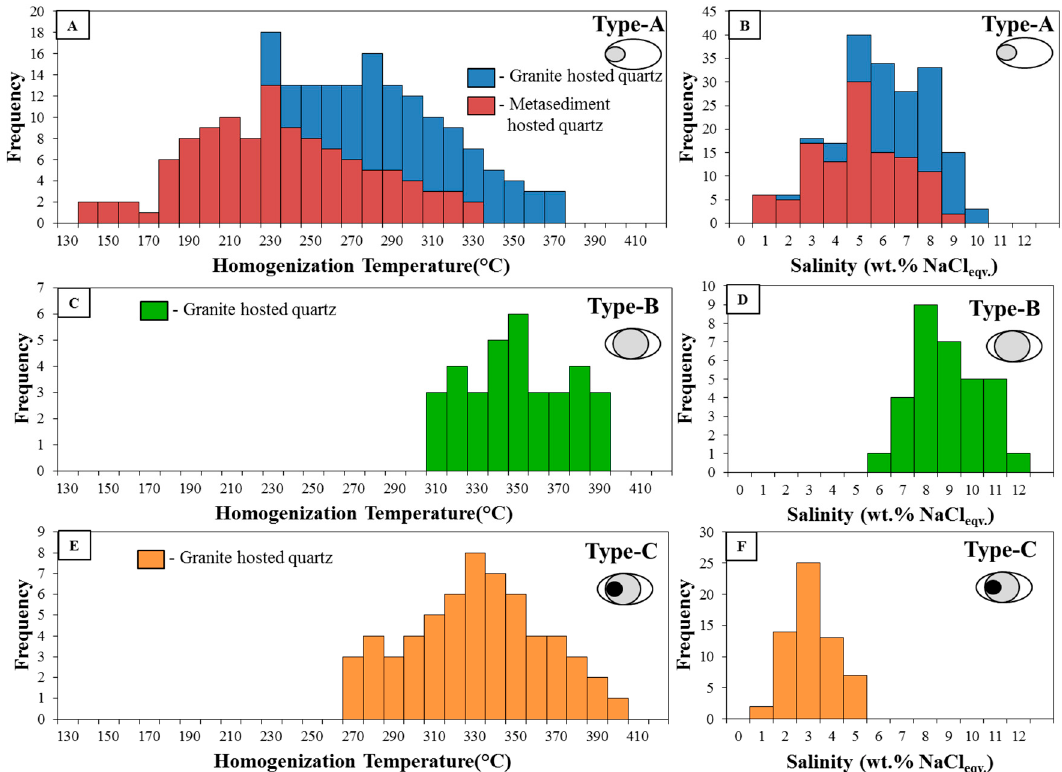
Figure 13. Histograms of microthermometric data for fluid inclusions in the Tagu Sn–W deposit. ( A ). Homogenization temperature of type-A fluid inclusions from granite and metasedimentary hosted quartz veins; ( B ). Salinity of type-A fluid inclusions from granite and metasedimentary hosted quartz veins; ( C ). Homogenization temperature of type-B fluid inclusions from granite hosted quartz veins; ( D ). Salinity of type-B fluid inclusions from granite hosted quartz veins; ( E ). Homogenization temperature of type-C fluid inclusions from granite hosted quartz veins; ( F ). Salinity of type-C fluid inclusions from granite hosted quartz